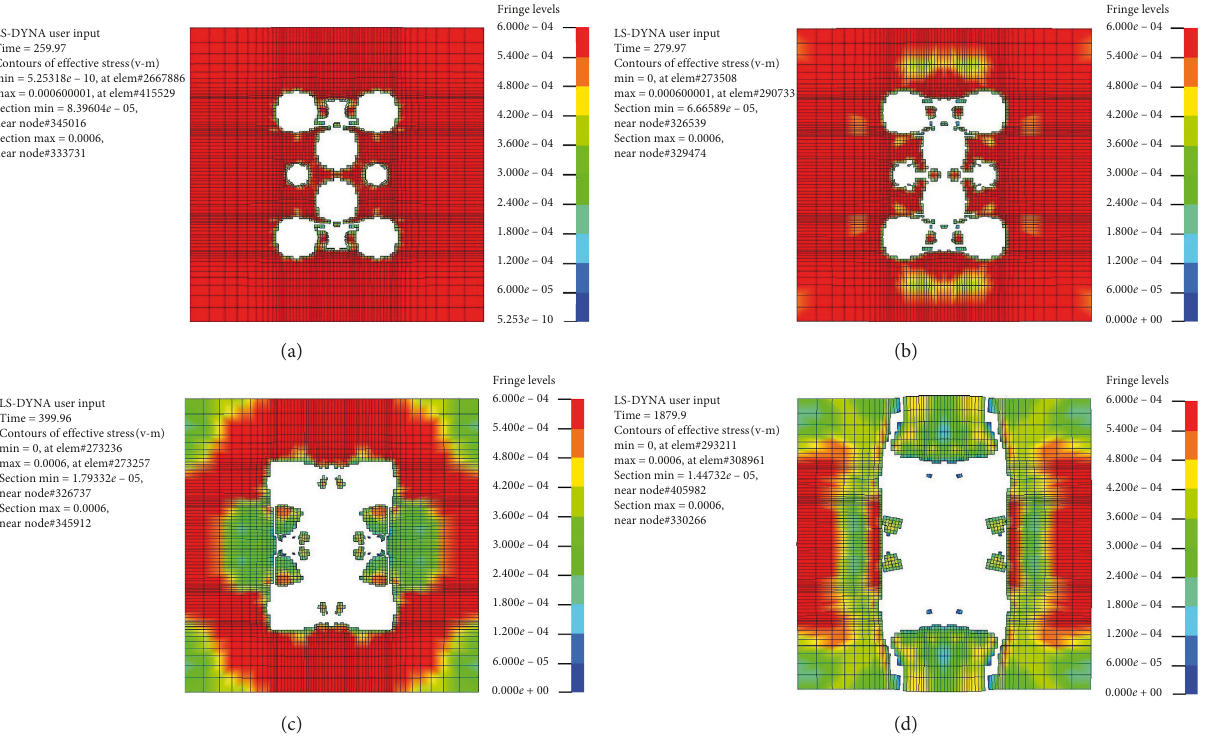
Figure 4: Temporal and spatial evolutionary cloud diagram of effective stress of four holes. (a) 260 μ s. (b) 280 μ s. (c) 400 μ s. (d) 1879 μ s.